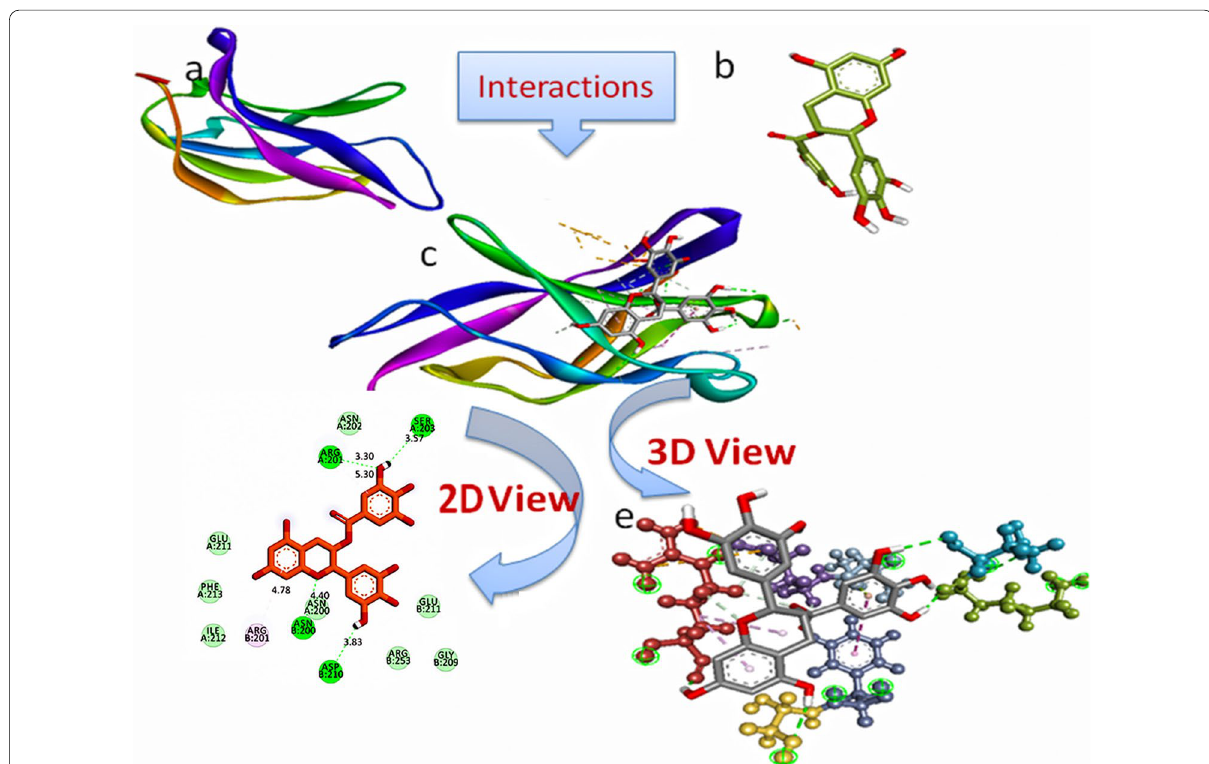
Fig. 3 Autodock of 1BFT (NF-kB p50) with